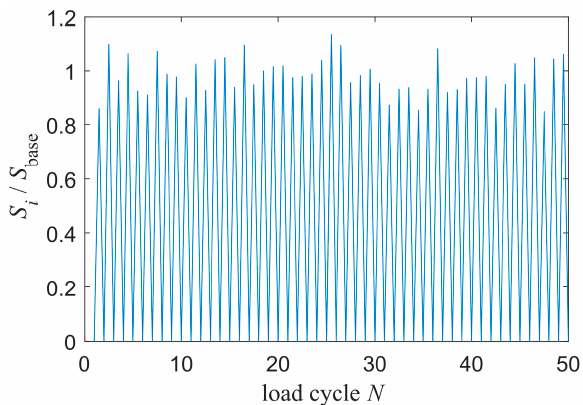
Figure 6. Normalized representation of random load sequences.